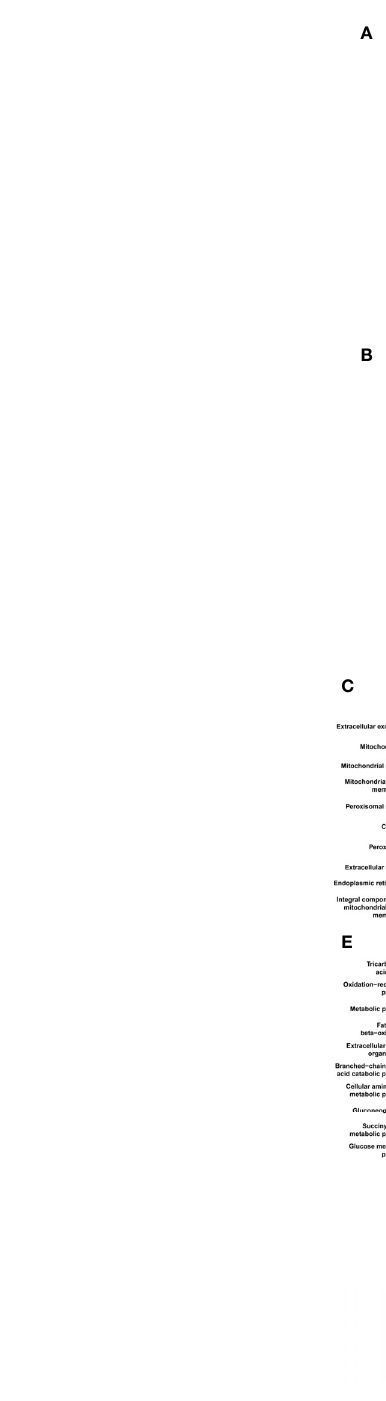
FIGURE 5 | SDHB may suppress ccRCC tumorigenesis and development by inhibiting glycolysis. (A) Co-expression network of SDHB gene in ccRCC. Genes that were negatively correlated with SDHB were displayed in green, and genes that were positively correlated with SDHB were displayed in red. The darker the color, the stronger the correlation. (B) PPI network of SDHB-related DEGs. (C – E) Bubble chart according to GO (cellular component, molecular functions and biological processes) analyses of SDHB-related differentially expressed proteins. (F) KEGG pathway enrichment analysis of SDHB-related differentially expressed proteins. (G) Enrichment plot of gene expression signature for glycolysis (HALLMARK_GLYCOLYSIS). The ccRCC samples from TCGA_KIRC database were divided into high and low SDHB expression groups according to the median value of SDHB RNA-seq quanti fi cation